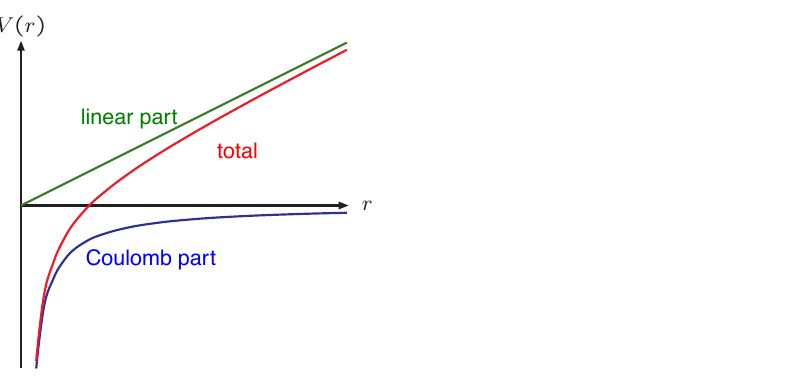
Figure 3. An illustration of the total static quark potential as a function of interquark